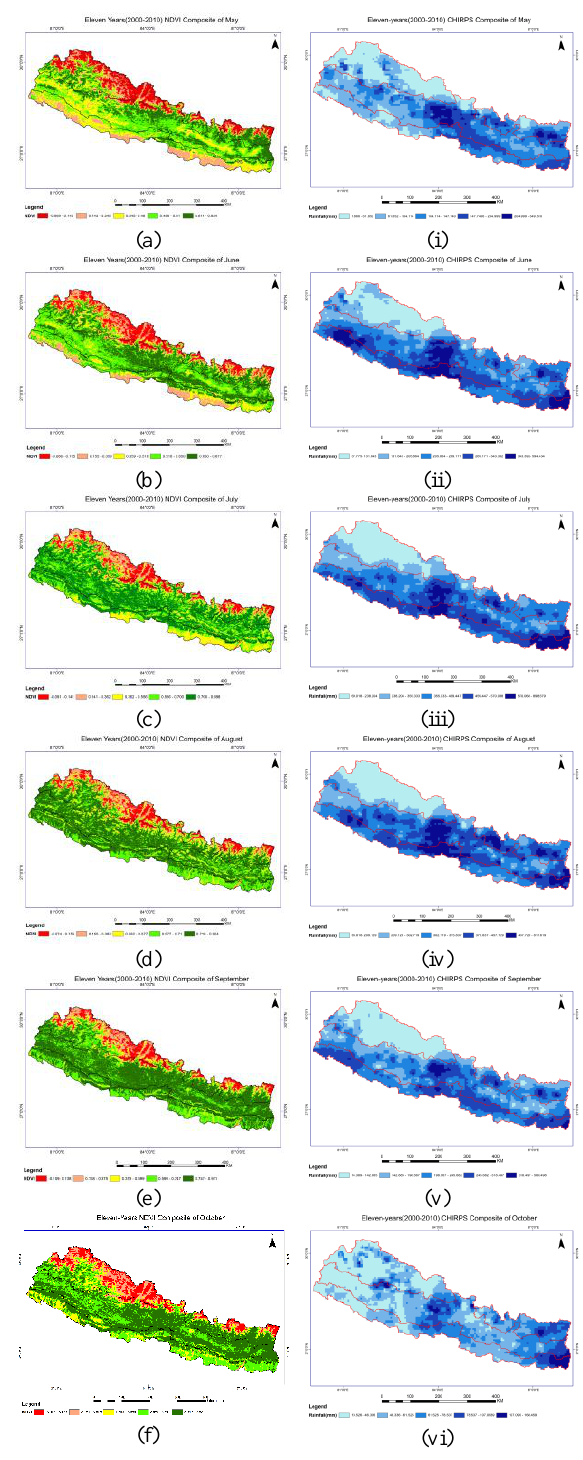
Figure 5. Map showing NDVI eleven-years composite for (a). (i). May, (ii). June, (iii). July, (iv). August, (v). September and (vi).